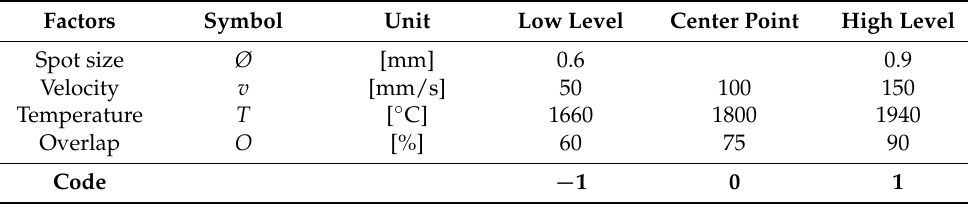
Table 2. Table 1. Factors, levels and coded values of the design of experiments.